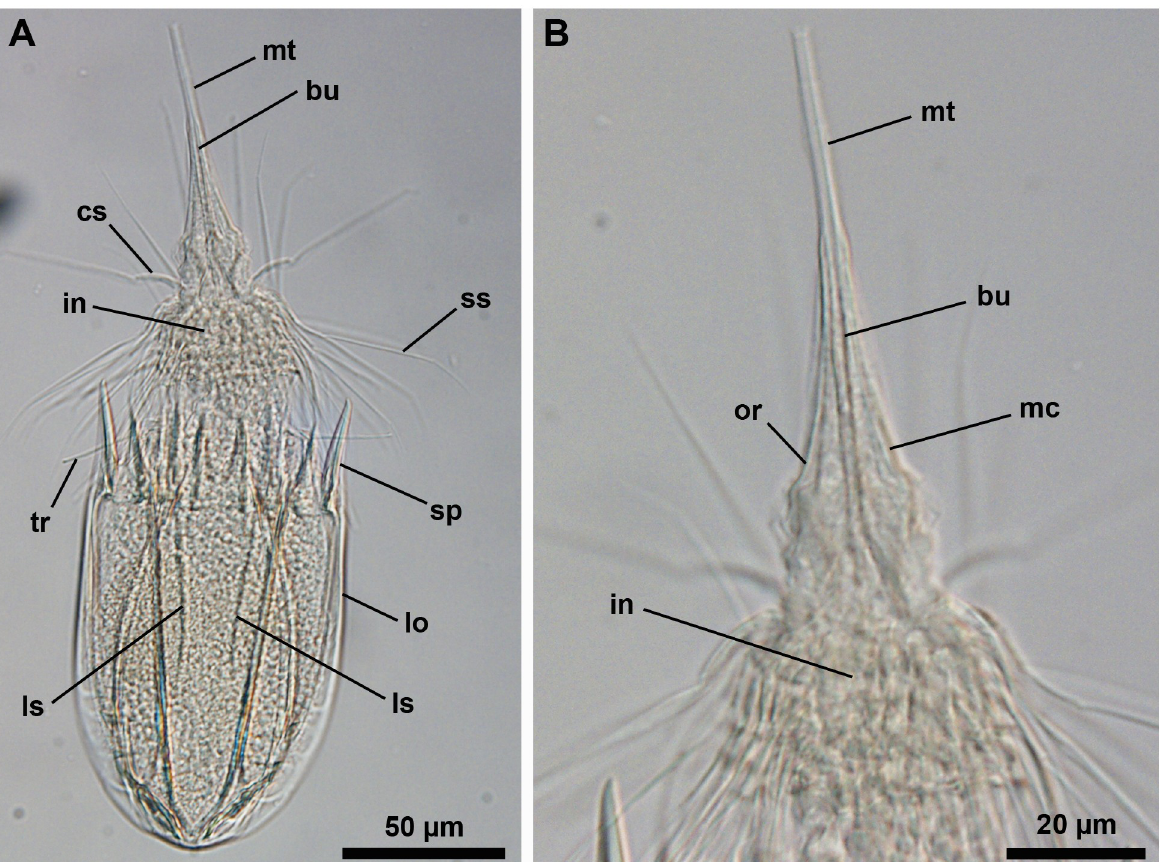
Fig 5. Light micrographs of a paratypic adult female of Nanaloricus valdemari sp. nov. Anterior faces up in both aspects, dorsal view. (A) Overview of the specimen with extended introvert and fully extended mouth tube. (B) Close-up of the anterior region of the body. Abbreviations: bu, buccal tube; cs, clavoscalids; in, introvert; lo, lorica; ls, longitudinal stripe; mc, mouth cone; mt, mouth tube; or, oral ridge; sp, anterior spike; ss spinoscalid; tr, trichoscalid.